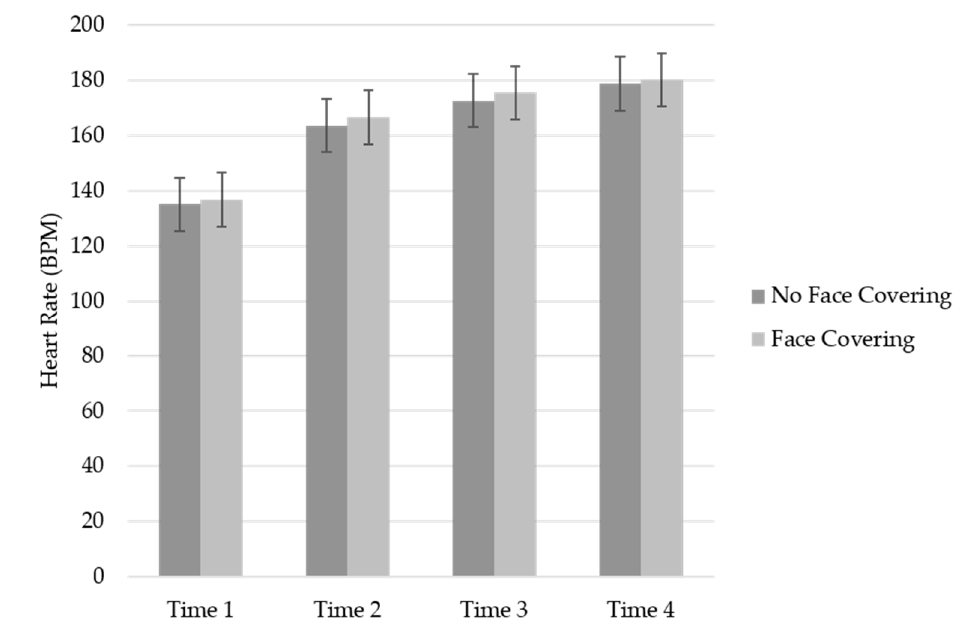
Figure 1. Mean HR across time by